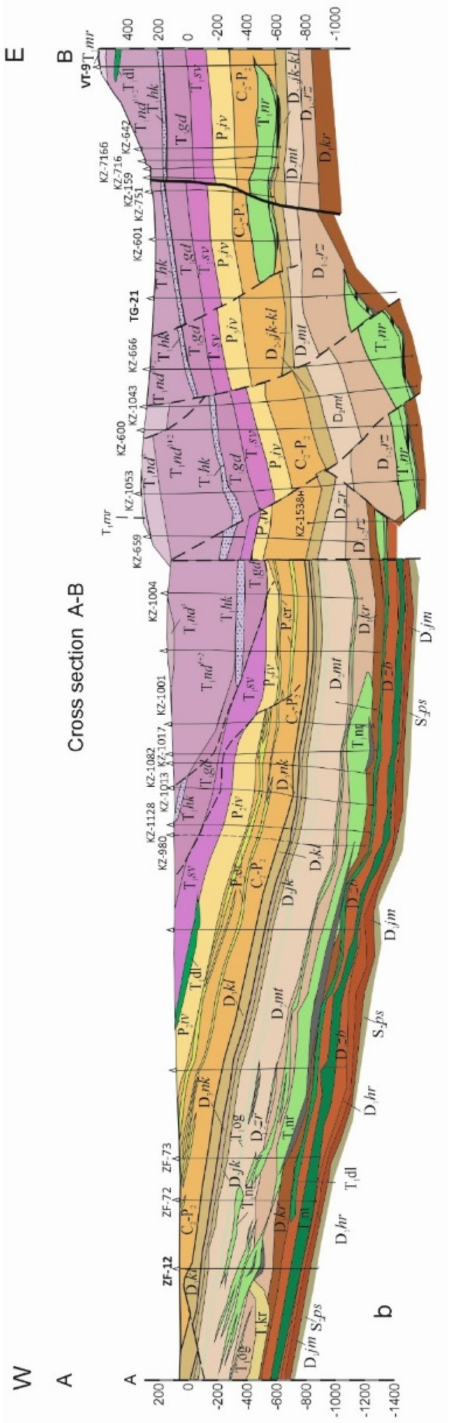
Figure 4. Geologic map ( a ) and cross section ( b ) of the Kharaelakh intrusion (after the Norilskgeology Ltd. data, with the authors’ changes). This area is indicated as “1” in Figure